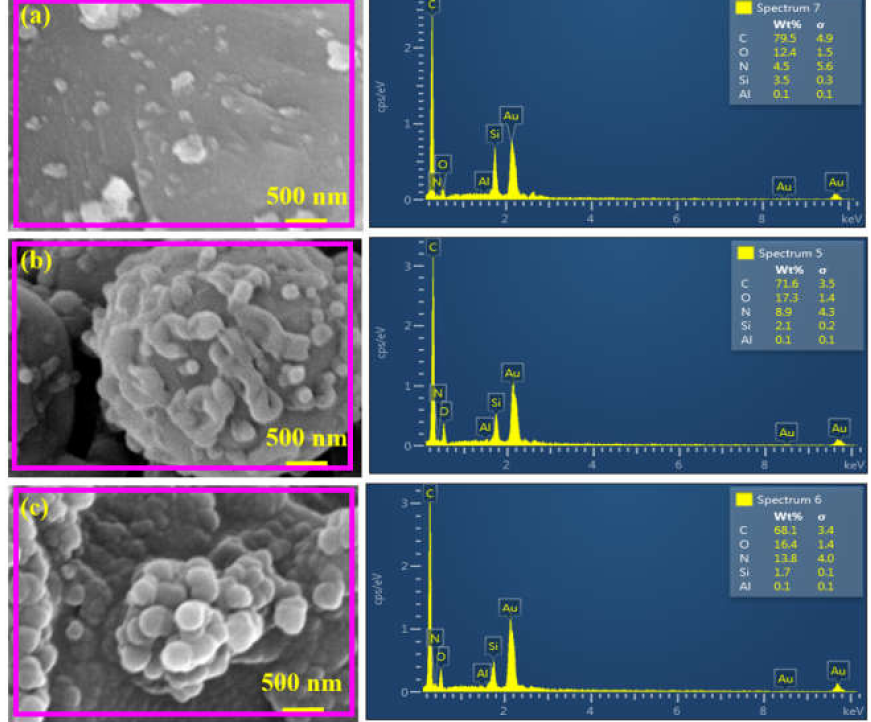
Figure 6. EDX analysis of ( a ) M-50, ( b ) M-100 and ( c ) M-200